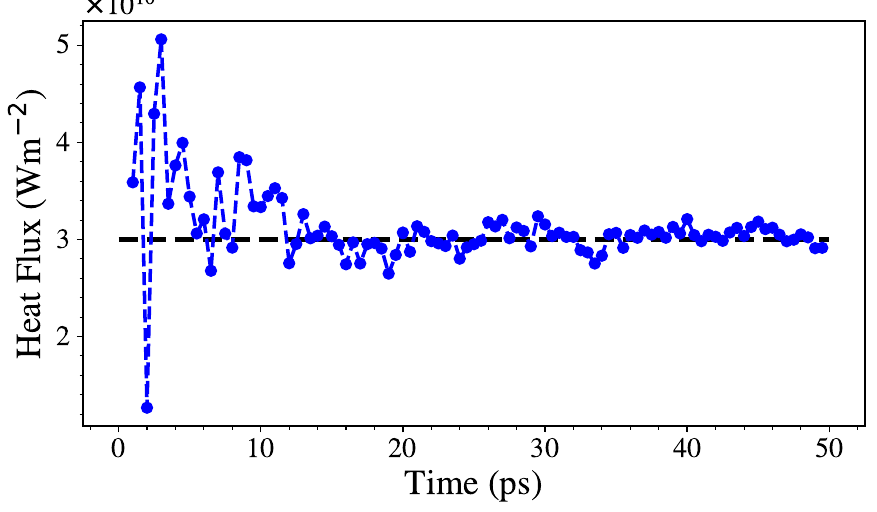
Figure 3. Heat flux vs. time for a 20% sp 3 NT with 1 and 2 nm of internal and external radii, at 300 K. The dashed line show the flux value use in the